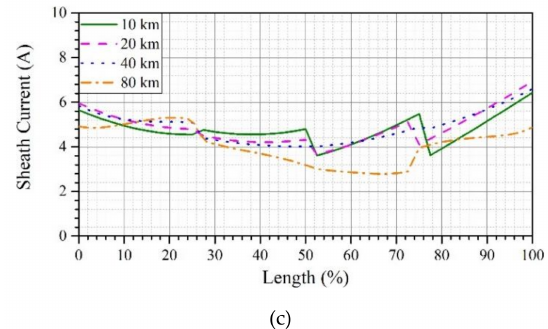
Figure 12. Steady state sheath circulating currents along length of 10, 20, 40 & 80 km cable ( a ) Terminal Grounded (TG). ( b ) Multipoint Grounded (MPG—2 segments) ( c ) Multipoint Grounded (MPG—4